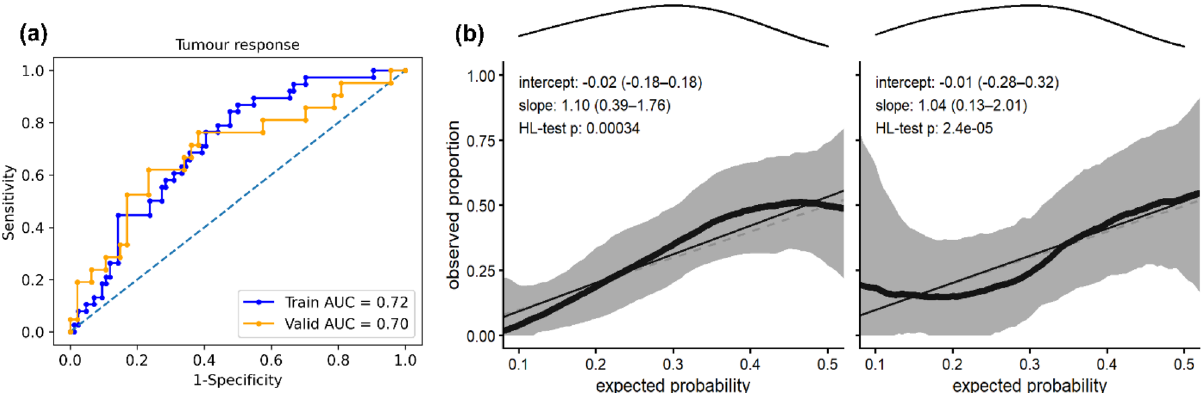
Figure 2. ( a ) Receiver operating characteristics (ROC) curves and ( b ) calibration plots for tumour response prognosis in training (left) and validation (right) resulting from best performing joint signature combining clinical T stage and Laplacian of Gaussian (LoG) features from T2w-MRI and CT. For calibration, data (thick lines) and 95% confidence intervals (shaded regions) are shown together with linear regression lines (solid lines) that follow the optimal expectation (dashed lines). Density of expected probabilities is shown above the calibration plot.